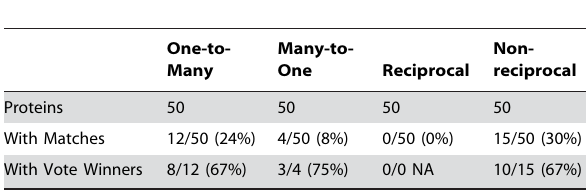
Table 4. ETA Annotation of Non-enzyme Set.